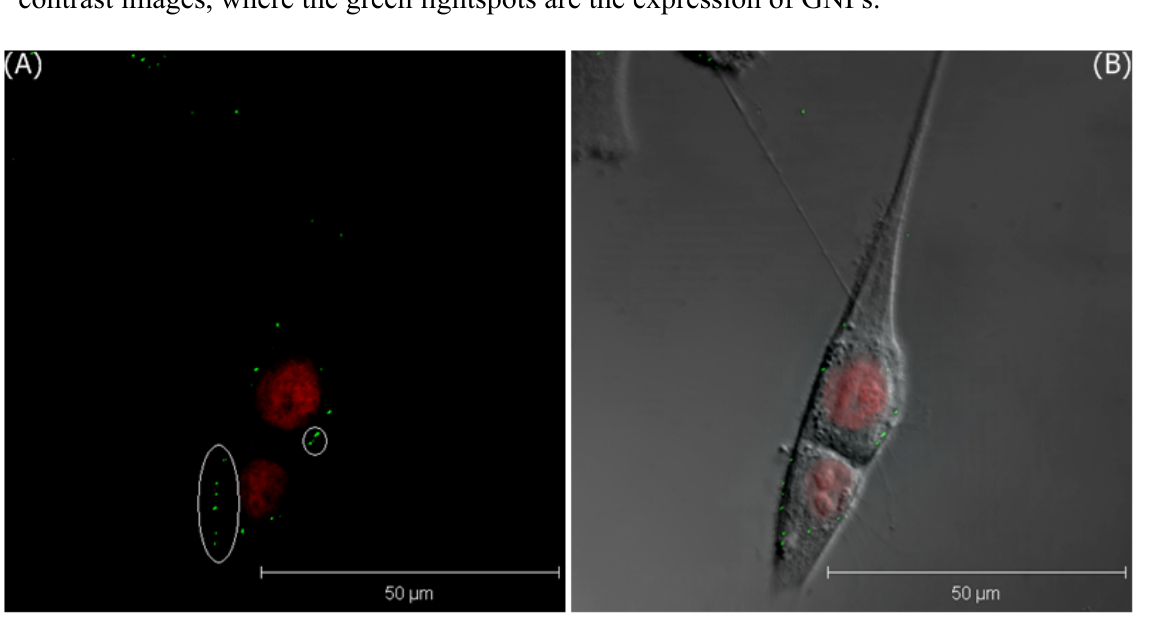
Figure 8. The 3D projection images of MDA-MB-435S cells incubated with GNPs-FA in media after 5 minutes; A) LSCM image, and B) the merged image of LSCM and the phase contrast images, where the green lightspots are the expression of